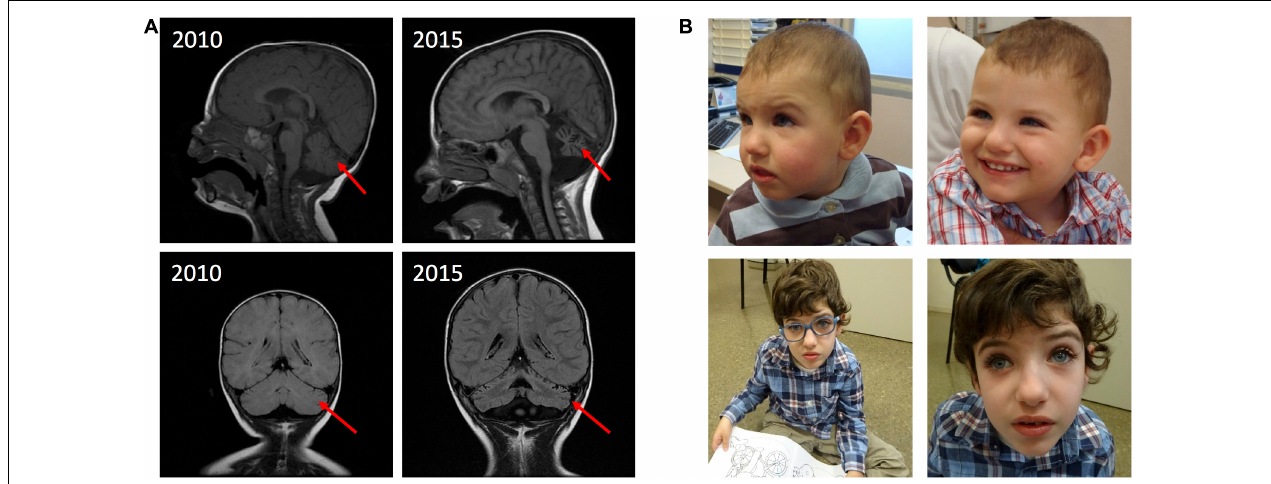
FIGURE 1 | MRI findings and pictures of the patient. (A) MRI showing progressive cerebellar atrophy. (B) Patient at 1 year of age (top left), at 1 year and 9 months of age (top right) and at 8 years of age (in the